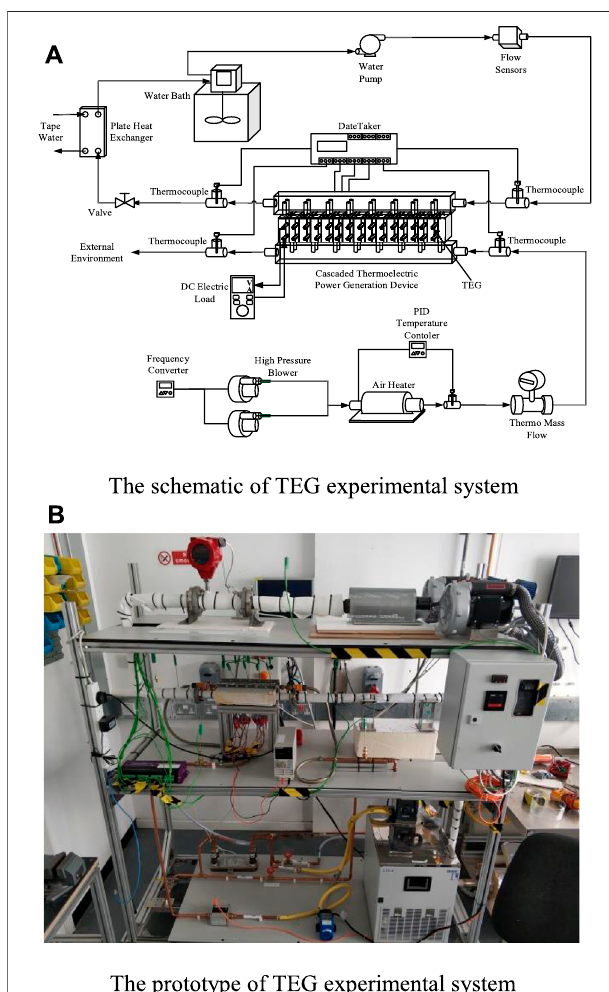
FIGURE 3 | (A) Schematic of the TEG experimental system. (B) Prototype of the TEG experimental